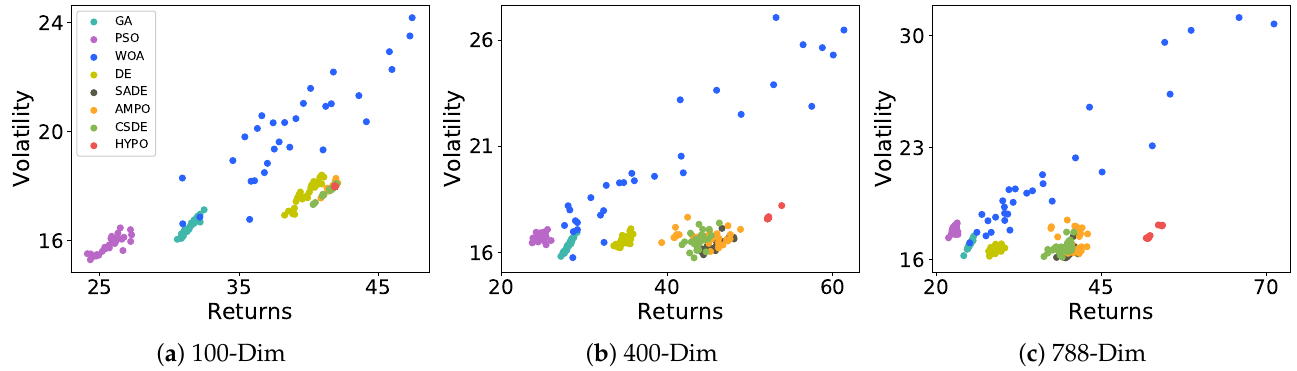
Figure 7. Visualization of Mean-variance Distribution on the CSI300 Set.